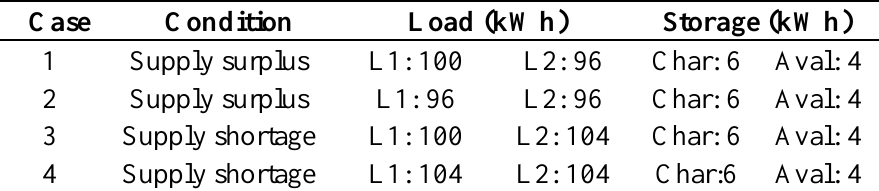
Table 4 Operation condition of Cases 1–4.